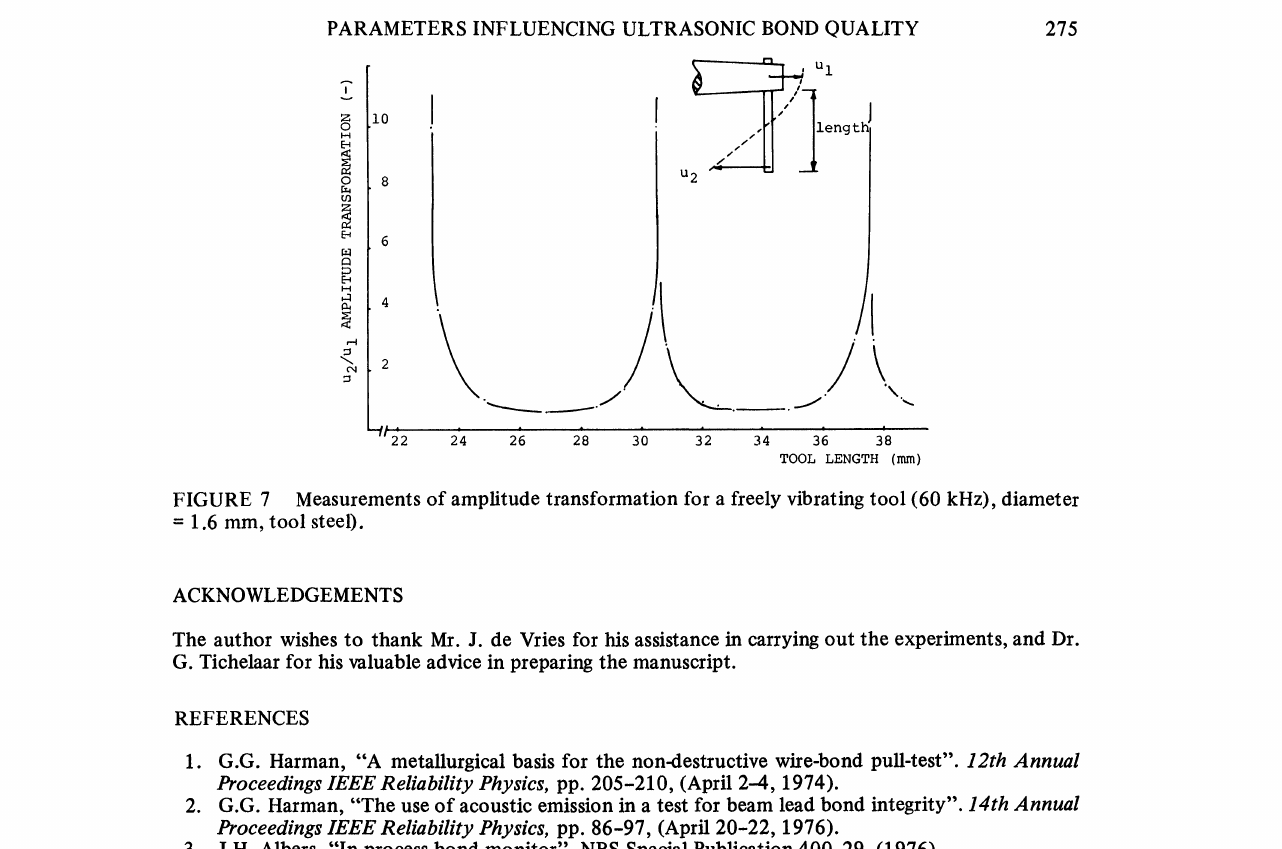
Measurements of amplitude transformation for a freely vibrating tool (60 kHz), diameter 1.6 mm, tool